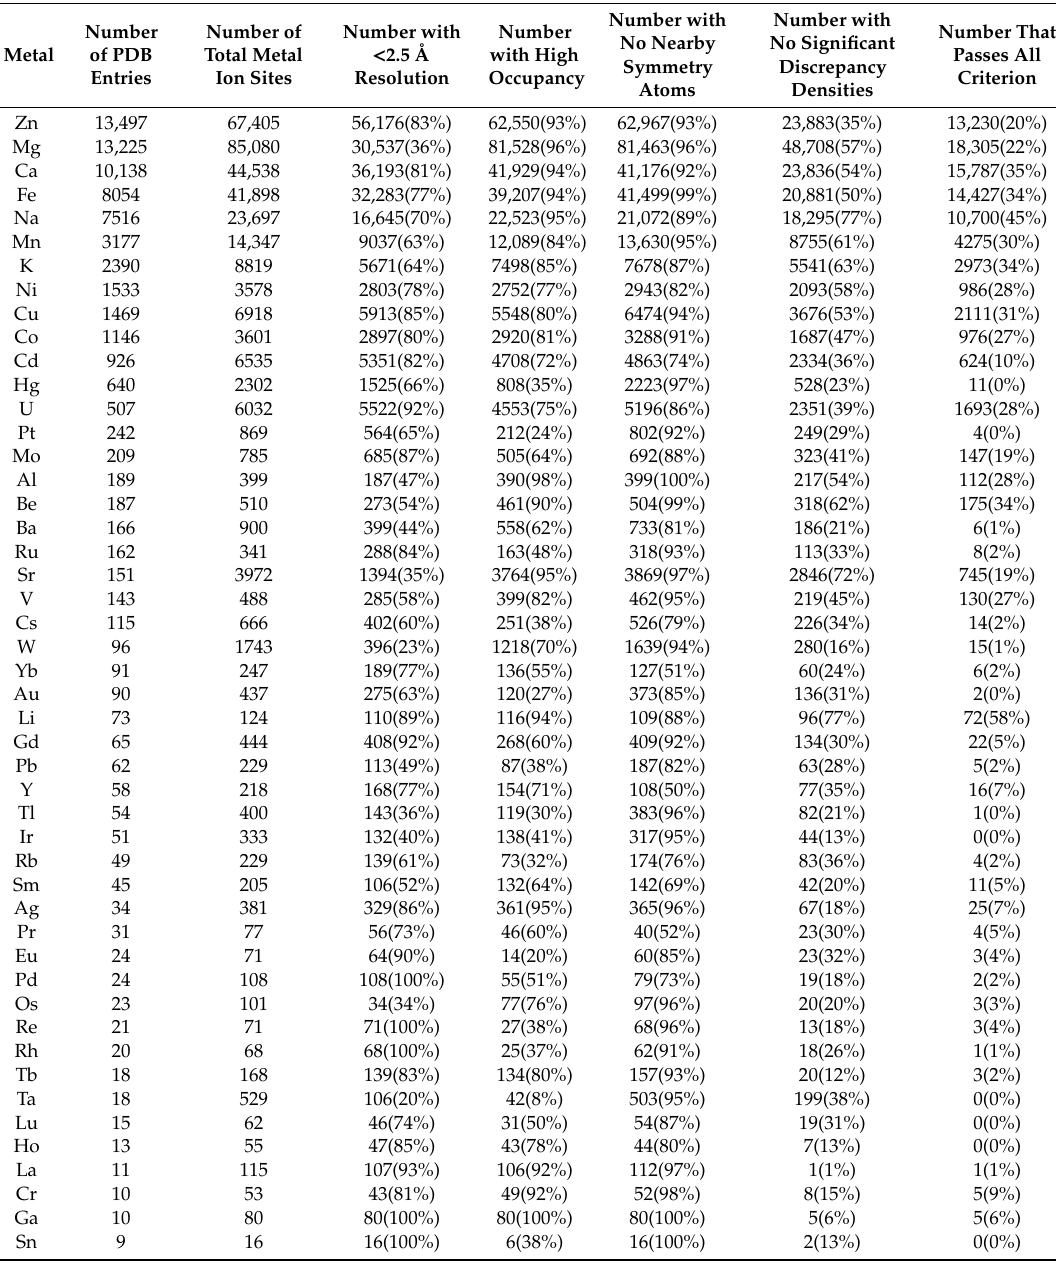
Table 1. Tabulation of di ff erent elemental types of metal ions observed in the worldwide Protein Data Bank (wwPDB) with respect to four quality-control